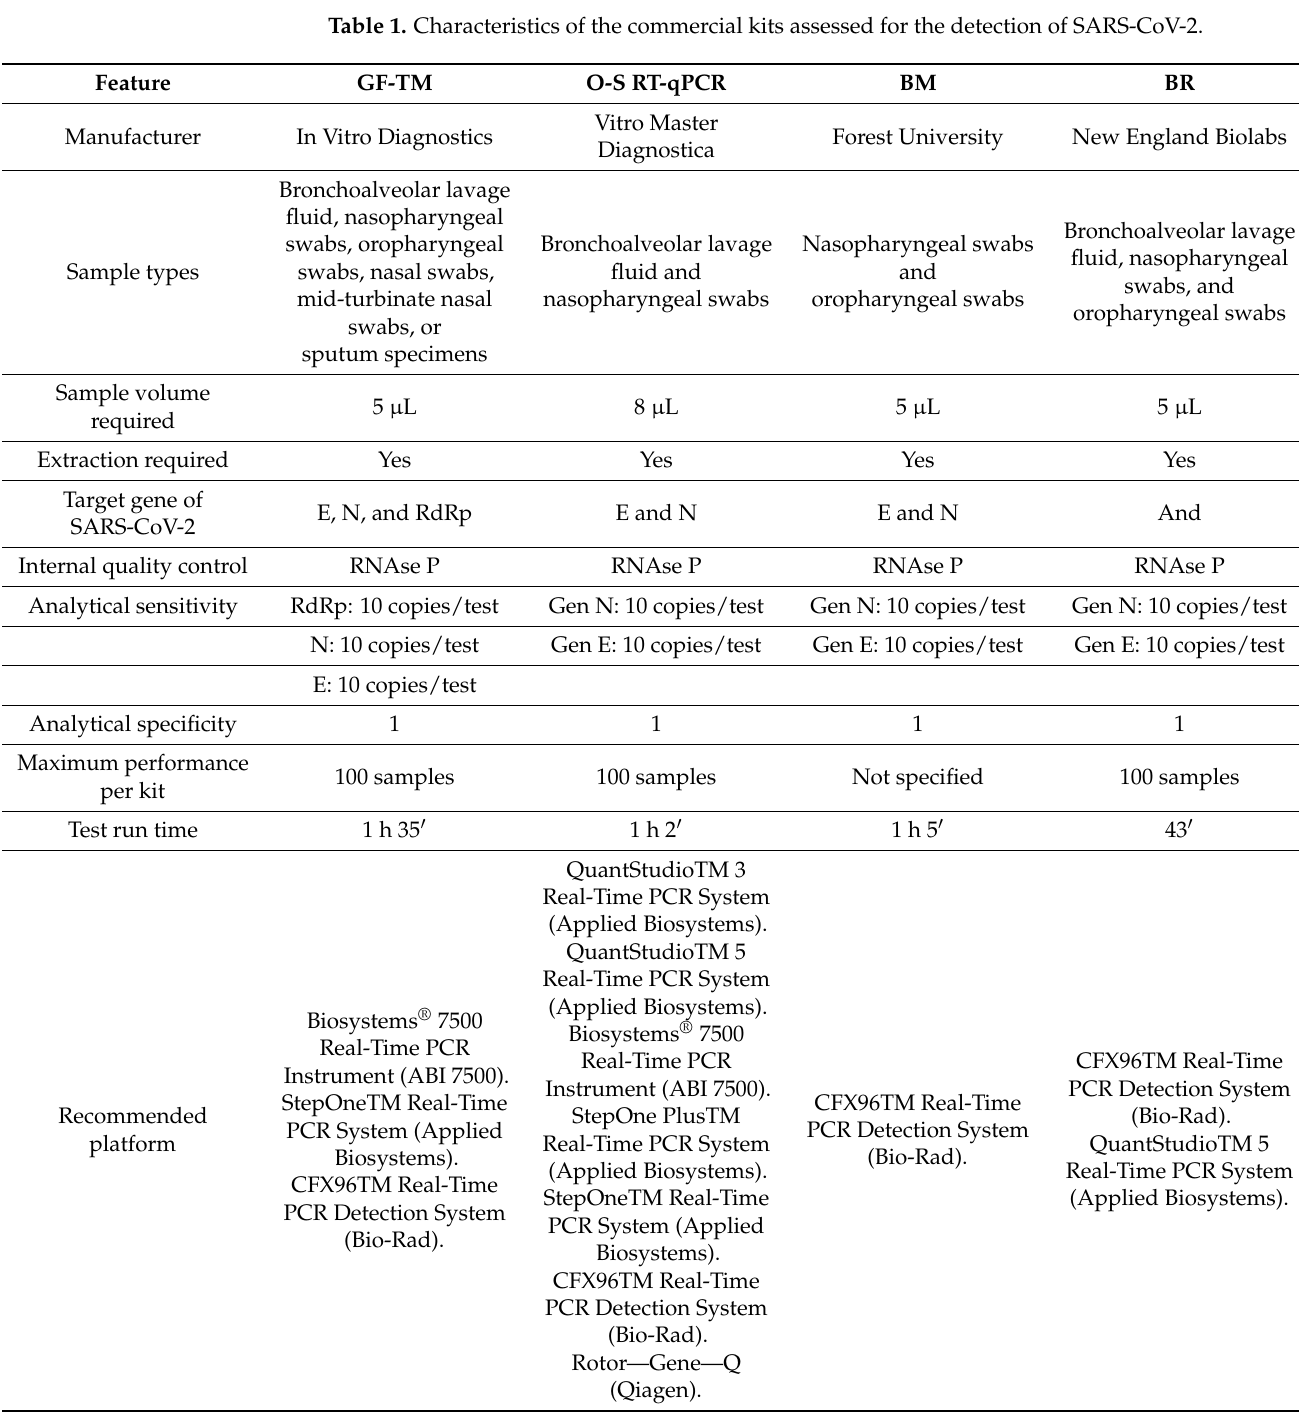
Table 1. Characteristics of the commercial kits assessed for the detection of